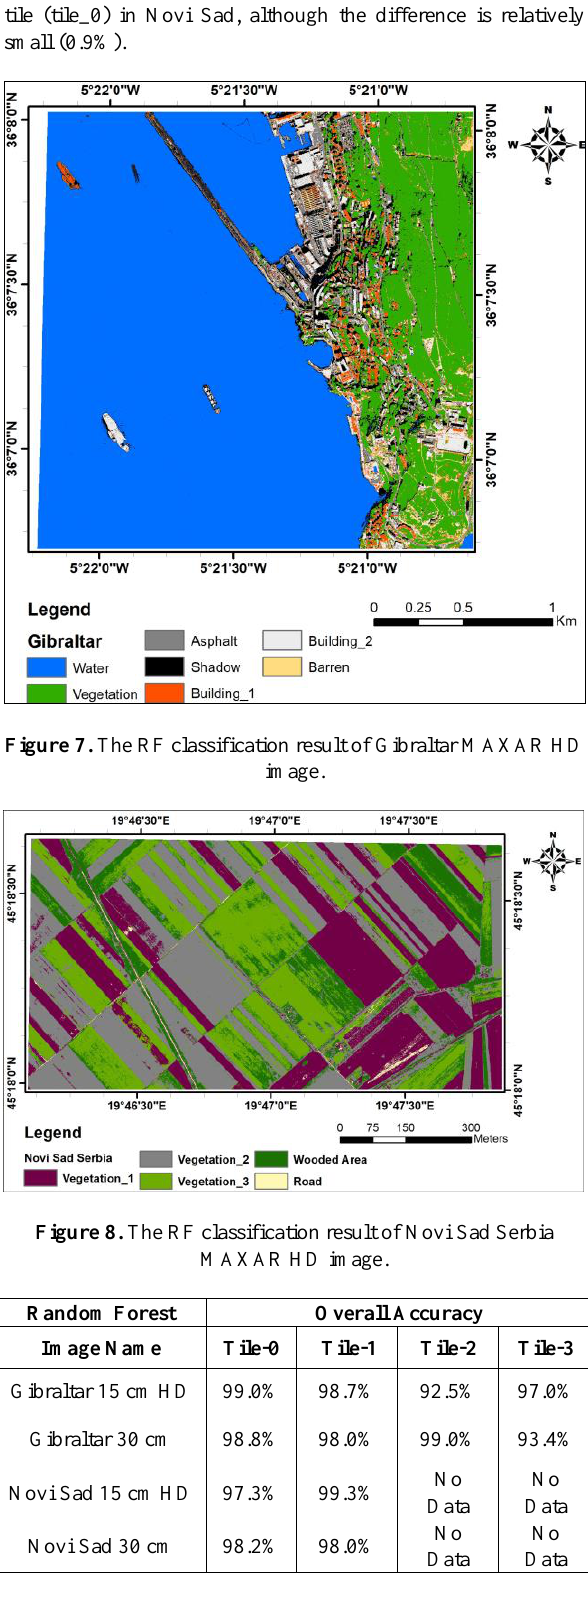
Table 3. The overall accuracy values obtained from the RF model results for all tiles in both